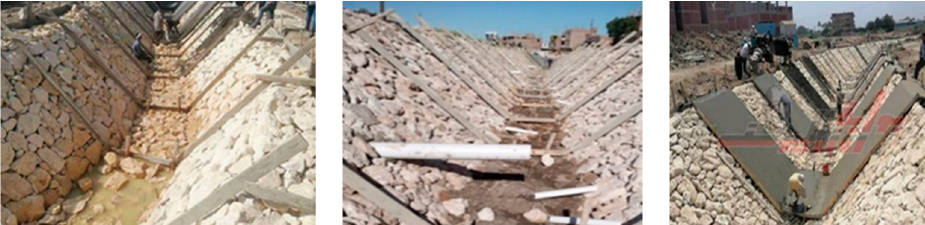
Figure 2. Technological sequence of canal lining in Nag-Hammadi in Egypt. Table 1. Dimensions of stone and thickness of boulder lining according to Egyptian code. Canal